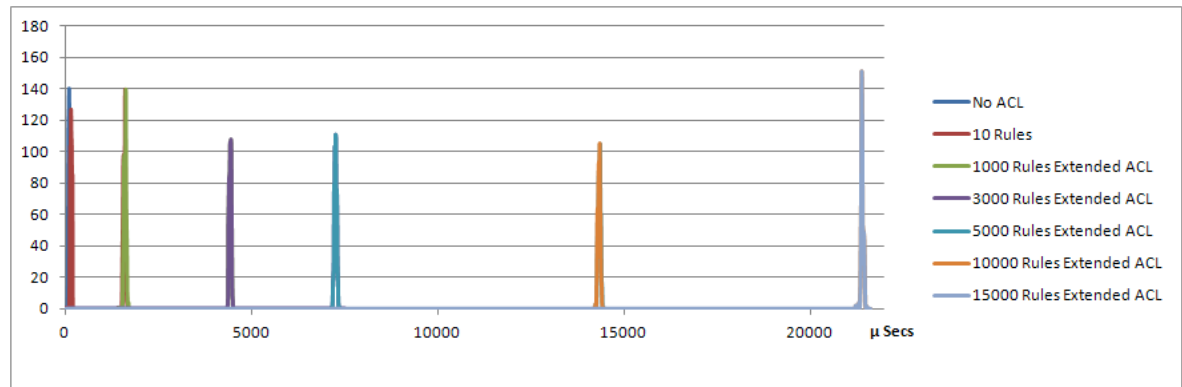
Figure 4. Delay through router with Basic